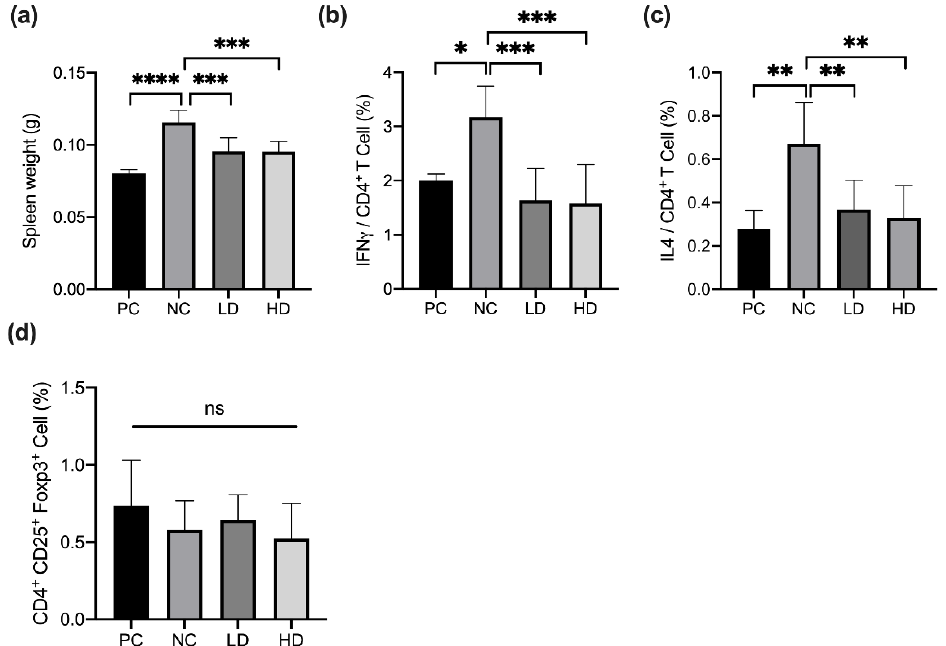
Figure 3. A combination of heat-killed MP01 and MP02 strains rebalanced the proportion of Th1 and Th2 cells in the spleen of HDM-extraction-induced AD mice. ( a ) The spleen weight of mice after treatment for 46 days. The population of ( b ) IFN- γ + CD4 + T cells, ( c ) IL4 + CD4 + T cells, and ( d ) CD4 + CD25 + Foxp3 + T cells in the spleen of test mice. The columns and the error bars represent means ± SD (n = 7–10/group). Data were analyzed using a one-way ANOVA with Tukey’s multiple comparison test. * p < 0.05, ** p < 0.01, *** p < 0.001. Value represents means ± SD.